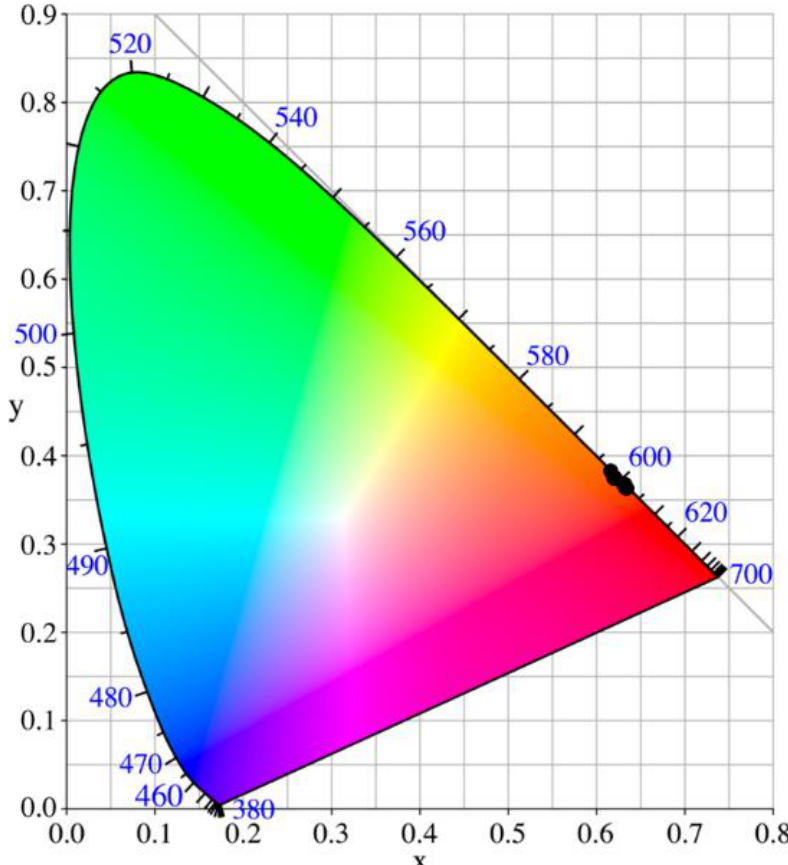
Figure 4. CIE coordinates of the emission of our samples. All samples are located in the red region.